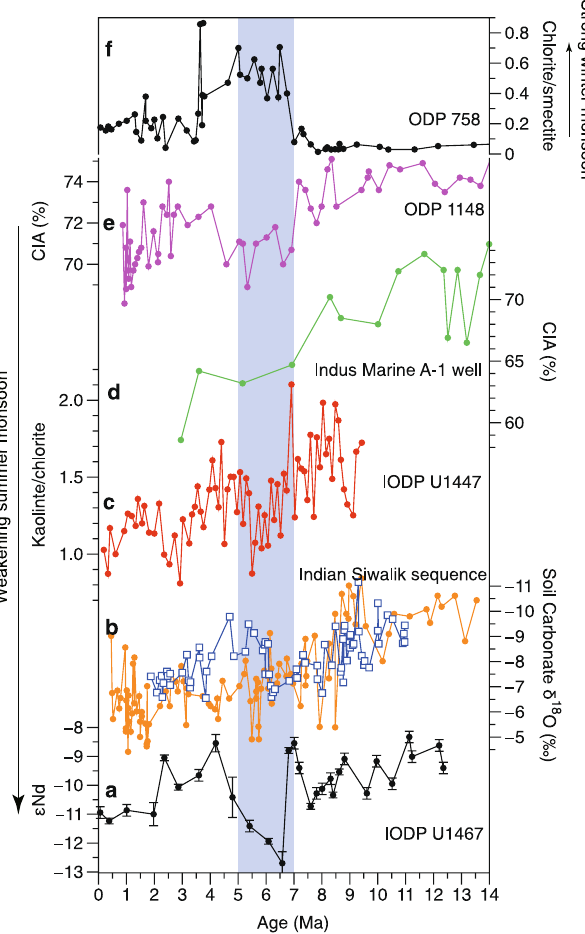
Fig.3|ComparisonsoftheSouthAsiansummermonsoon(SASM)proxieswith claymineraldatafromODPSite758during thelast ~12Myr.a Variationsin ε Nd (2sigma S.D.) at Site U1467 (this study). b δ 18 O of soil carbonate from the Indian Siwalikformation 46,47 . c Kaolinite/chloriteratiofromIODPSiteU1447inthewestern Andaman Sea 50 . d Chemical weathering proxies (CIA) from the Indus Marine A-1 well in the northern Arabian Sea 48 . e CIA index from ODP Site 1148 in the northern South China Sea 49 . f Chlorite/ smectite ratio of ODP Site 758 54 . The vertical shaded area represents the time interval of ~7 –